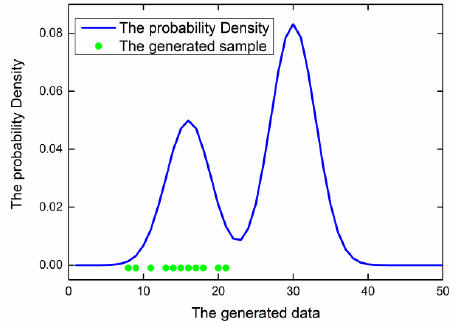
Figure 6. The duplicate samples and missing modes.